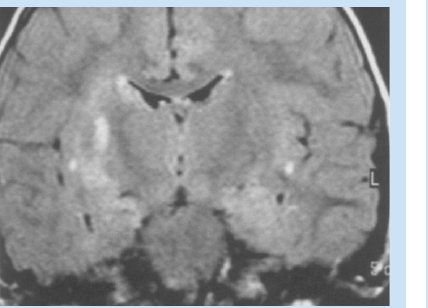
Fig 1d. Coronal FLAIR image at a more posterior level showing a focal hyperintensity in the right lentiform nucleus and subinsular white matter.